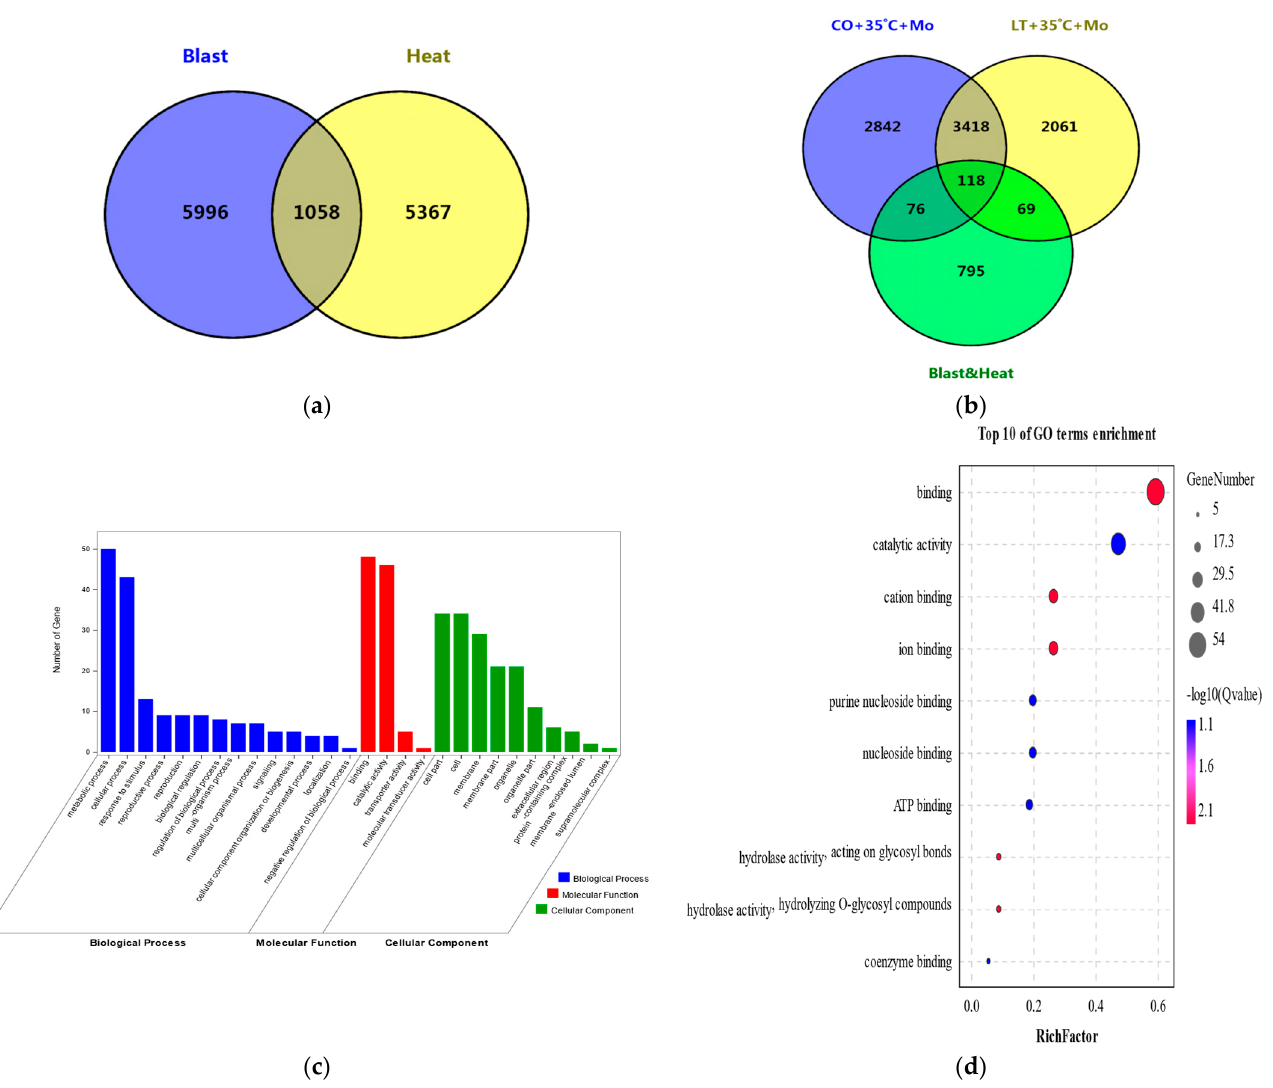
Figure 3. Integration of meta-QTLs and DEGs related to blast resistance and heat tolerance in rice. ( a ) The common genes co-located on meta-QTLs of the two traits; ( b ) the common genes of meta-QTLs and DEGs; ( c ) Go terms of 118 common DEGs co-located on meta-QTLs of the two traits; ( d ) the top 10 GO term enrichment of 118 common DEGs co-located on meta-QTLs of the two traits.